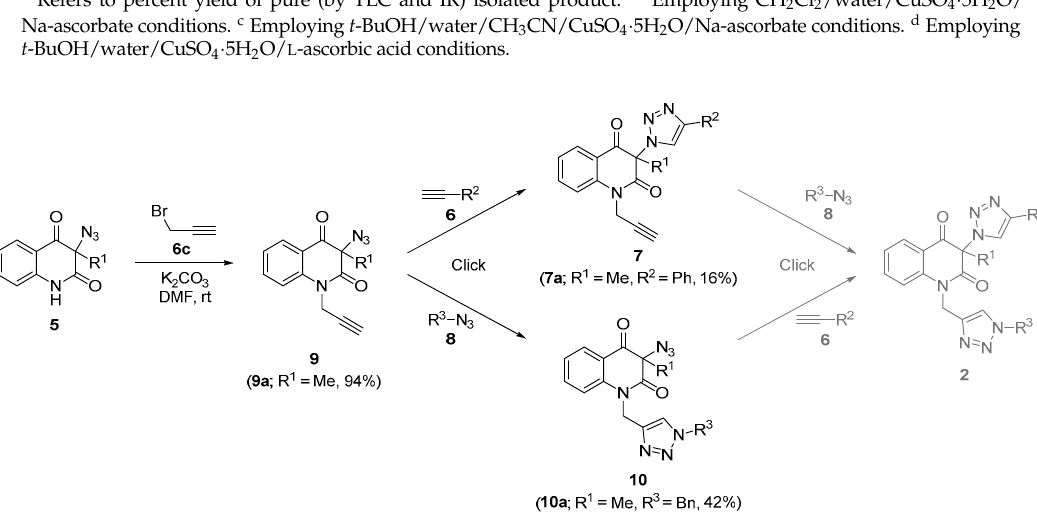
Figure 2. Selected ring and atom numbering along with the chemical shift data (mean values rounded up to whole numbers are provided). The 13 C and 15 N chemical shifts for triazole rings A and D (Tables 5 and 6) are in a good agreement with those reported previously [11]. To preliminarily assess the applicability of bis-triazole compounds 2 as ligands, we decided to examine their coordination abilities to arene-ruthenium. NMR experiment was designed in which compound 2b and equimolar amount of ruthenium (0.5 equiv of [RuCl( μ -Cl)( η 6 - p -cymene)] 2 ) were mixed in CDCl 3 in NMR tube at room temperature. CDCl 3 was selected as the reaction solvent in place of the coordinative DMSO- d 6 to avoid possible interference with the metal center (Scheme 4). The reaction mixture was monitored by time dependent 1 H NMR spectroscopy indicating an instant change in the resonances for 2b and p -cymene ligands upon mixing to form a new set of resonances that remained unchanged over several days. As shown in Figures 3 and 4, both proton and carbon NMR resonances were severely broadened suggesting the presence of a dynamic process in the solution, presumably an equilibrium with the starting ligand, which can result from a relatively weak ligand-to-metal interaction. Unfortunately, broad NMR resonances prevented an unambiguous structure determination of the product [Ru–Cym]- 2b through the 2D NMR techniques due to overlap as well as lack of several indicative crosspeaks in the spectra, especially in 1 H– 15 N gs -HMBC. Nevertheless, the analysis of the available NMR data tentatively suggested the coordination of both 1,2,3-triazole rings to the Ru–Cym unit as indicated in Scheme 4. Although the coordination properties of the 1,2,3-triazole nitrogen atom N2 are weak, some of us have previously shown that such chelates can be greatly stabilized through an assistance of auxiliary ligand [22].